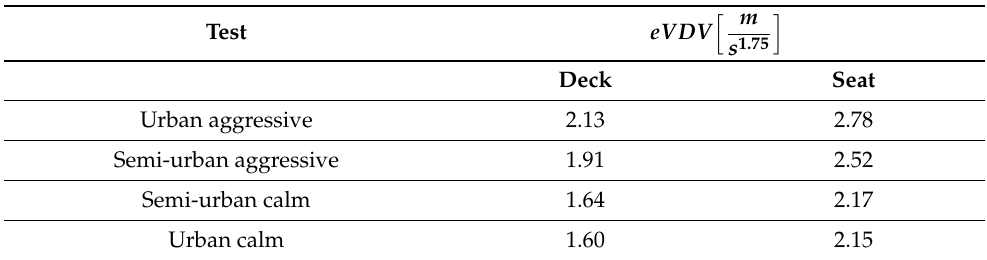
Table 2. Comfort Index validation, comparison between the observed eVDV at the seat and at the cabin